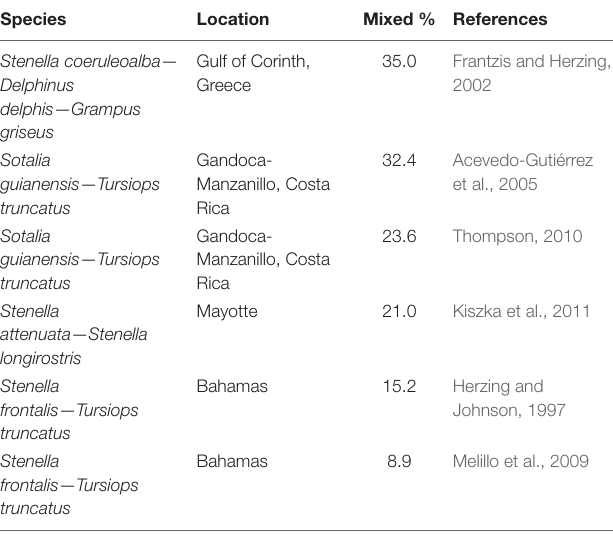
TABLE 3 | Mixed-species groups (MSGs) involving delphinids recorded as a percentage of all groups (i.e., single- and mixed-species groups) of particular populations of the listed species as obtained through dedicated studies of